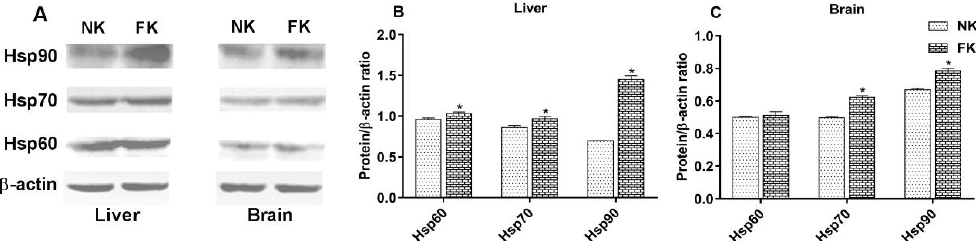
Figure 3. Protein bands of Hsps and β-actin ( A ), and protein expression of Hsp60, Hsp70, and Hsp90 in the livers ( B ) and brains ( C ) of laying hens with normal keel (NK) or fractured keel (FK). * p ≤ 0.05.